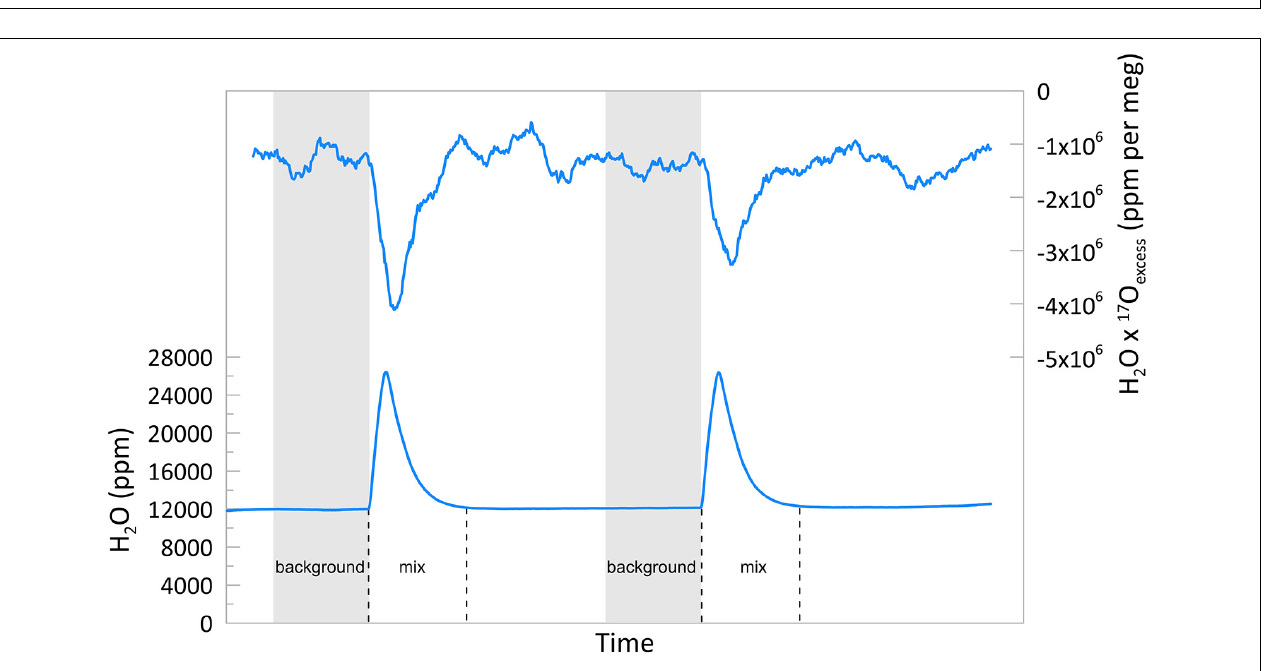
FIGURE 1 | Calibrations used for δ 18 O (A) , δ 17 O (B) , and 17 O excess (C) measured with the Picarro L2140- i for three different time periods (shown as different colors) between June 2016 and January 2017. For δ 18 O calibration we used GISP, ST-08 and Meerwasser standards. For δ 17 O and 17 O excess , we used Dome-C, Eiswasser and ST-08 standards. See Table 1 for assigned values.